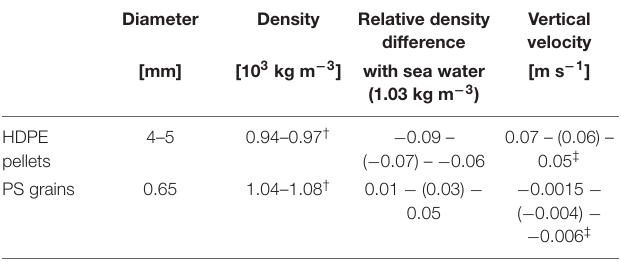
litter transport (Neumann et al., 2014), and 3D circulation (Ricker and Stanev,